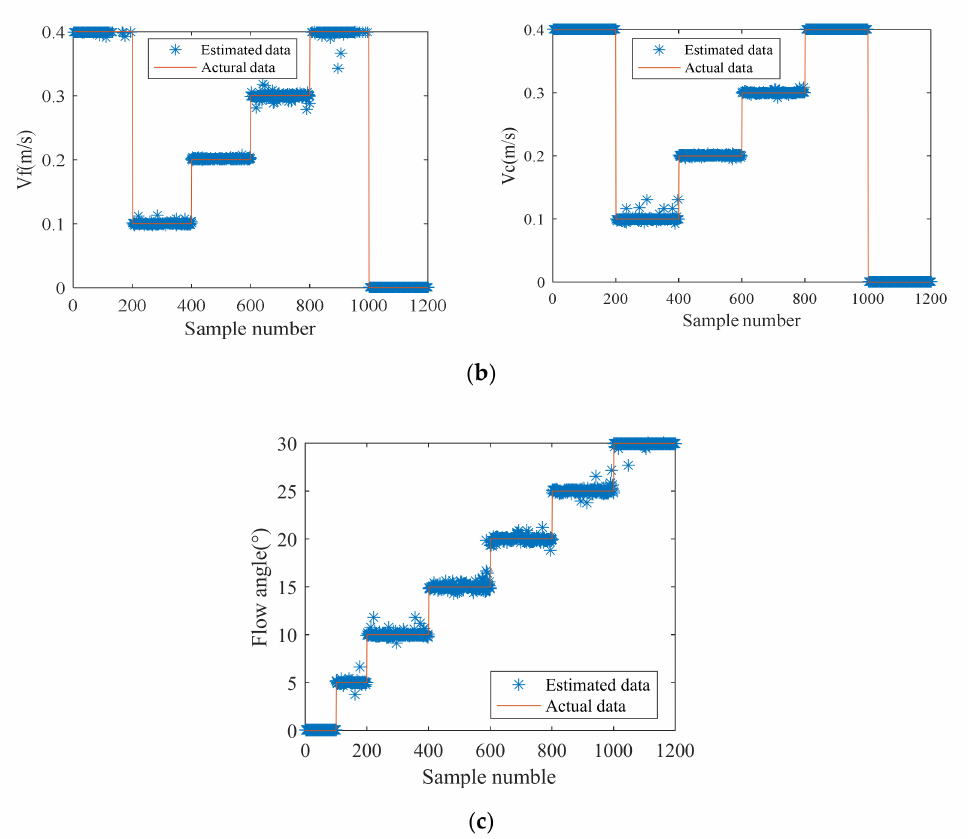
Figure 24. Comparison between estimated and actual results. ( a ) V f and V c in the opposite direction; ( b ) V f and V c in the same direction; ( c ) Flow